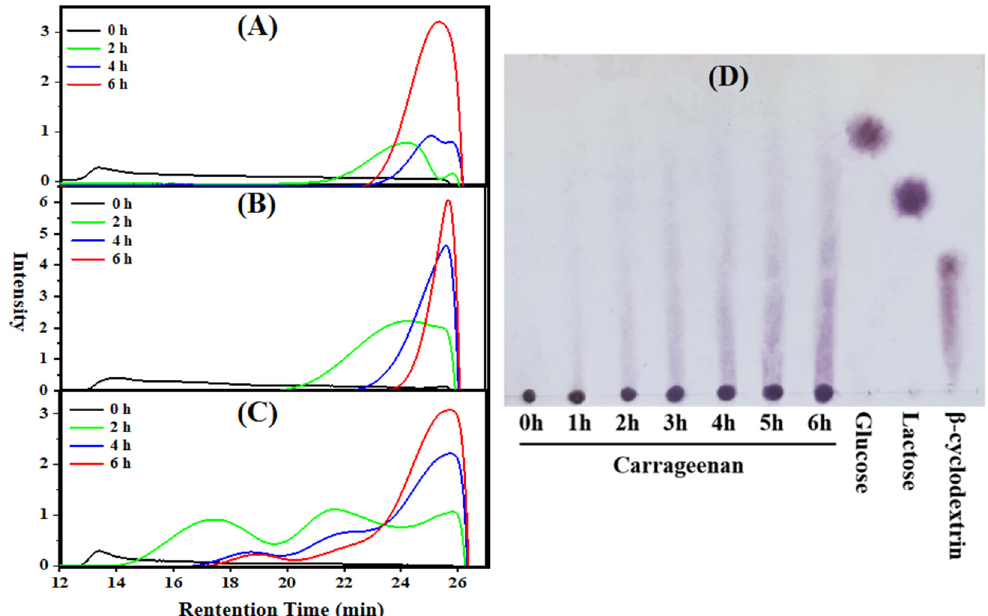
Figure 2. Molecular weight distribution changes of carrageenan during photocatalytic reaction mon- itored by HPGPC. ( A ) 300 mM H 2 O 2 , ( B ) 5% TiO 2 and 300 mM H 2 O 2 , ( C ) 5% TiO 2 , and ( D ) TLC with 5% TiO 2 of degraded carrageenan.